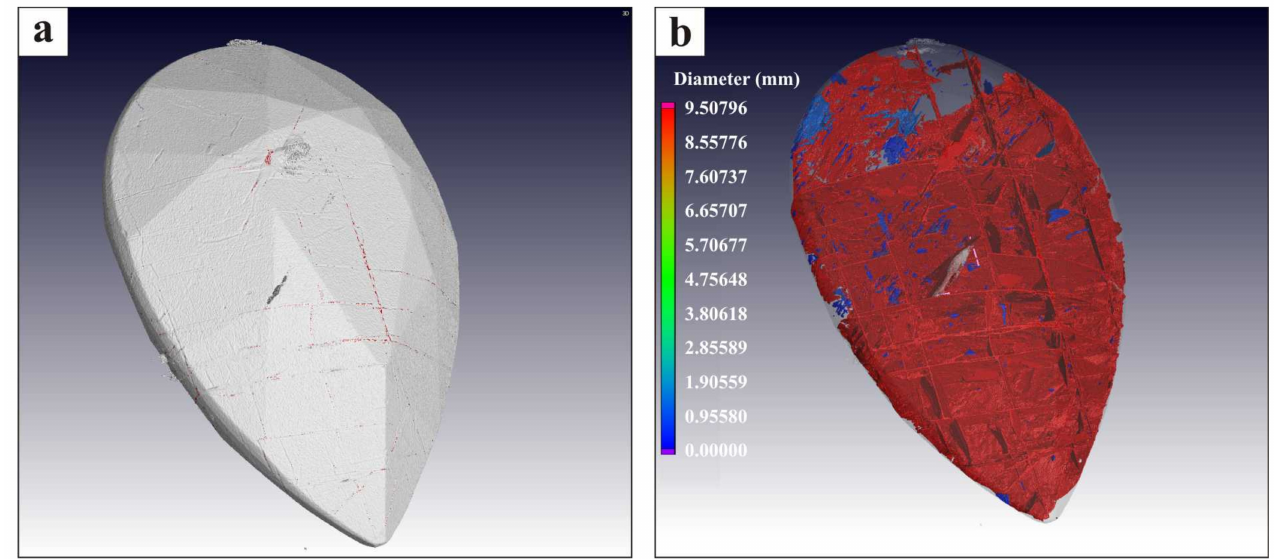
Figure 5. 3D CT-scan images of the EGL ruby (5 µ m scan), showing the surface ( a ) and the results of a color coded fracture filling diameter analysis ( b ). The largest, interconnected fractures are indicated in red, whereas the smaller, isolated fractures and cavities are shown in